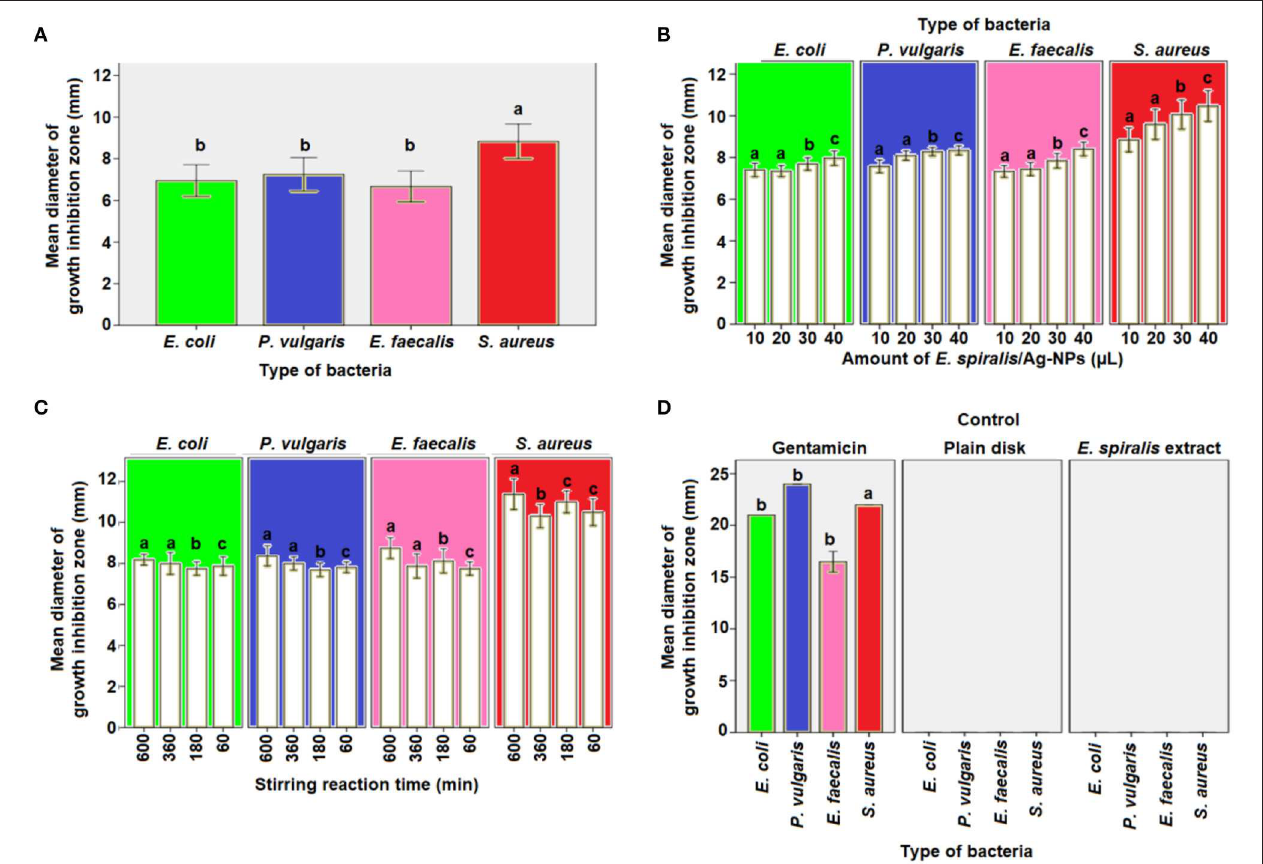
FIGURE 9 | The mean diameter of inhibition zones by E. spiralis /Ag-NPs at (A) different type of bacteria, (B) different amount of E. spiralis /Ag-NPs against different type of bacteria, (C) different stirring reaction time against different type of bacteria, (D) positive and negative control of antibacterial agent. Data with the same letter are not significantly different ( P >